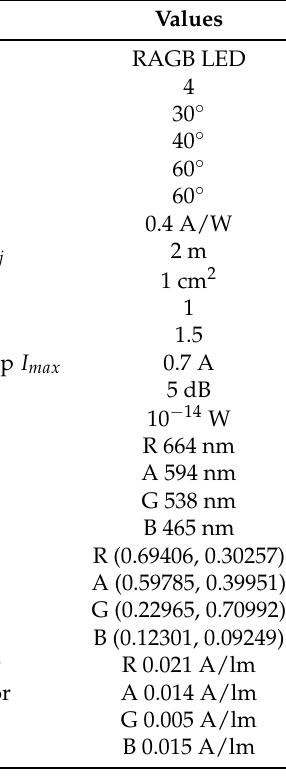
Table 2. Simulation parameters utilized in the QLED VLC